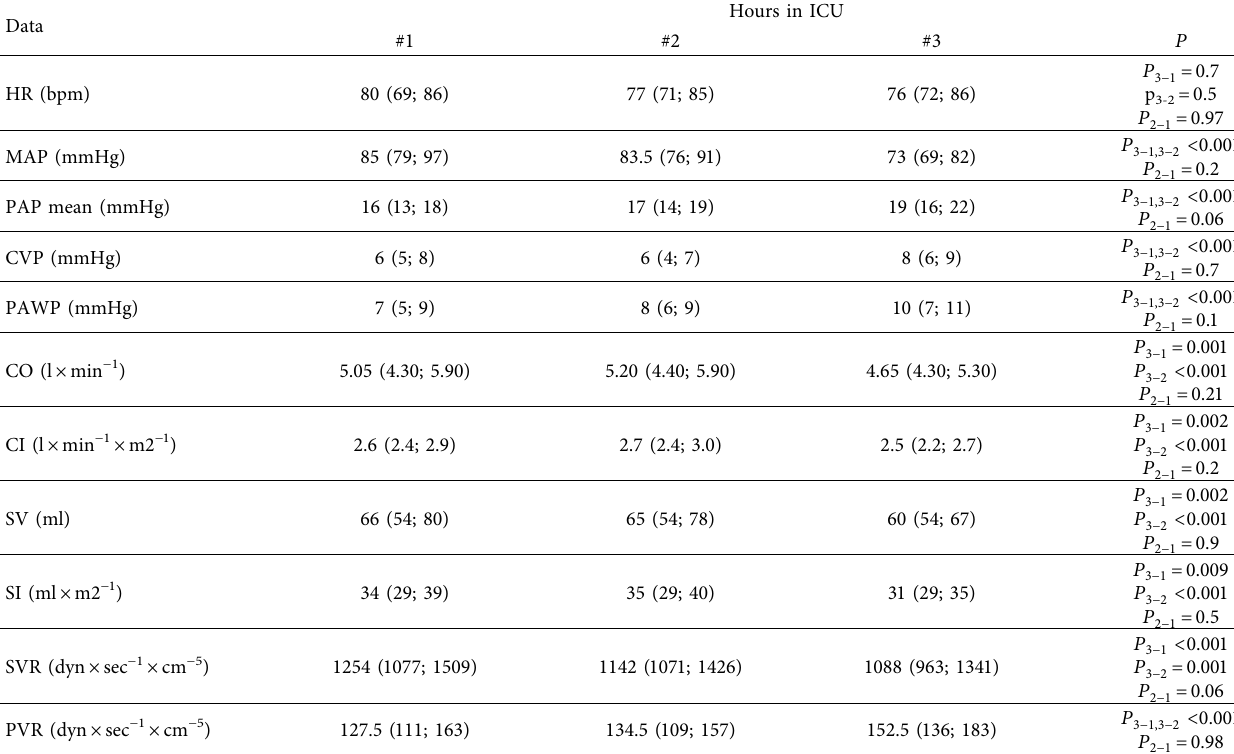
Table 3: Changes in hemodynamic profile in patients from the interventional group not requiring catecholamines for three hours of study, median (25 th ; 75 th percentile), n � 50.